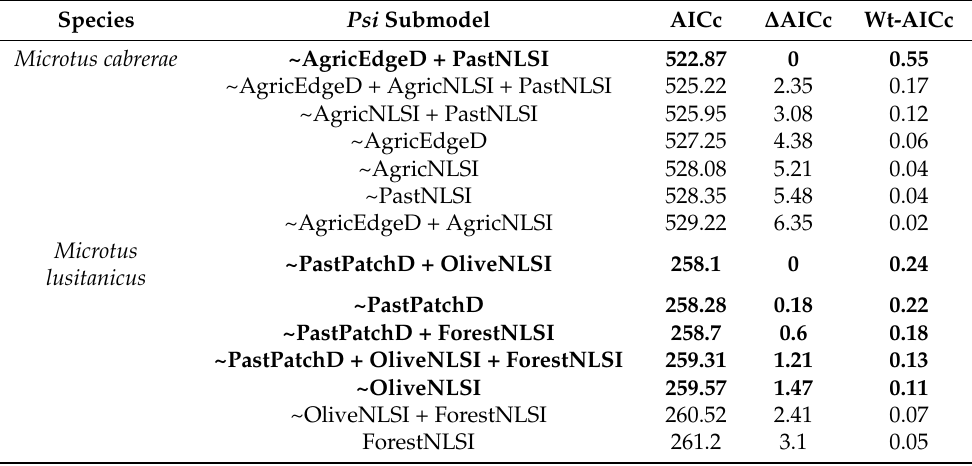
Table 4. AICc-based ranking of candidate models built to assess the effects of landscape vari- ables on Microtus cabrerae and Microtus lusitanicus occupancy in NE Portugal olive grove agro- ecosystems. In each case, the submodel structure for detectability included the effects of transect location ( p ~TransType). Most supported models for each species (delta AICc < 2) are indicated in bold. Species Psi Submodel AICc ∆ AICc